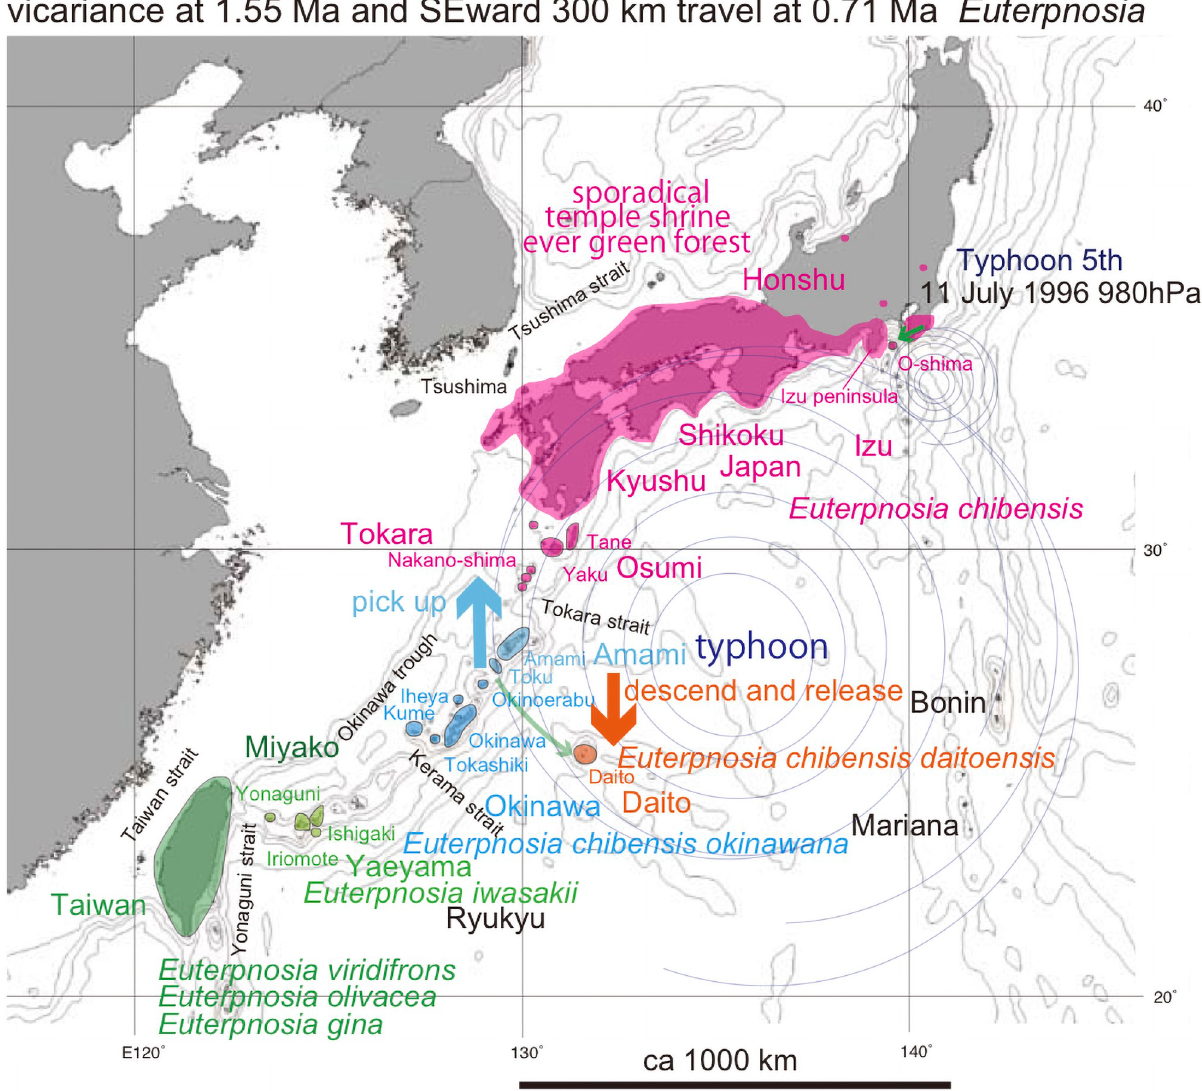
Fig 3. Distribution of Euterpnosia . Island populations are depicted by color highlights. See Discussion; Green anticlockwise curved tracks: Typhoon dispersal from Toku to Daito islands (SW part of map), and also from Honshu to O-shima (much shorter path on NE part of map). The bold short arrows schematically (not to scale) show where the typhoon winds picked up cicada (red) and where the same cicada were released (orange). Base map from Vector Map (VMap) Level 0, National Geospatial-Intelligence Agency.